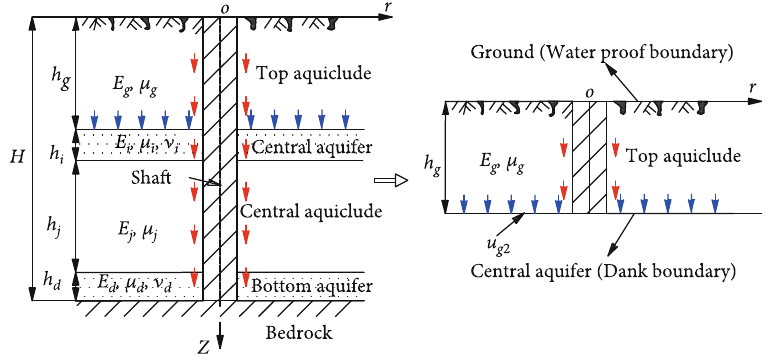
Figure 4: Schematic diagram of the single-slope drainage consolidation of the top aquiclude.